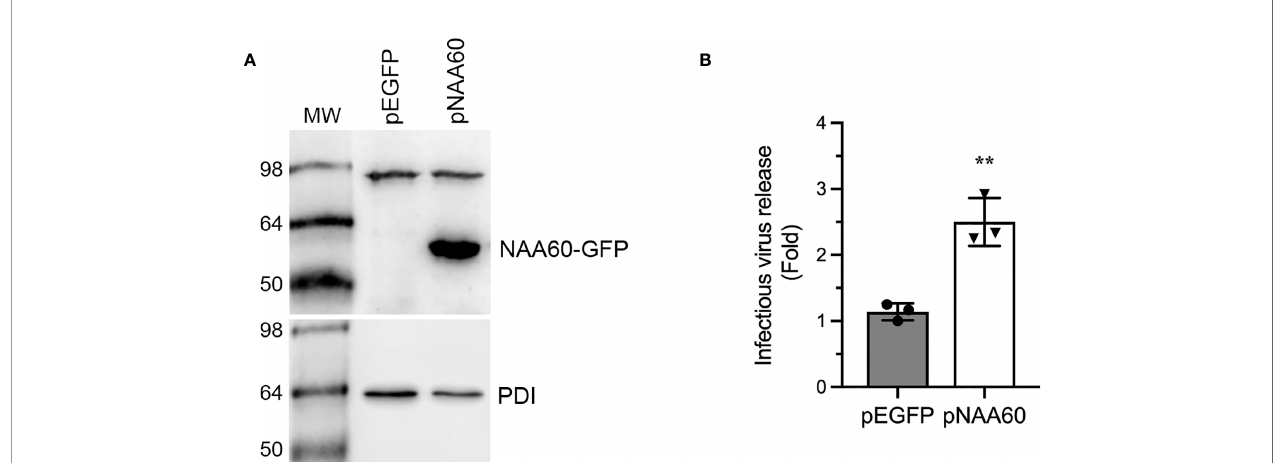
FIGURE 2 | The overexpression of NAA60 increases IAV infection. HEK293T cells were transfected with 1µg of pEGFP or pNAA60 plasmid for 24 h and subsequently infected with PR8 at an MOI of 1.0 for 24 h. (A) The cells were processed to detect the NAA60-GFP fusion (56 kDa) and PDI (57 kDa) polypeptides by western blotting. (B) The culture medium was titrated by microplaque assay to determine the viral progeny release. The amount of viral progeny released from pEGFP plasmid transfected cells was considered 1-fold to determine the viral progeny released from pNAA60 plasmid transfected cells. Error bars represent means ± standard deviation of at least three biological replicates; **P ≤ 0.01. MW, molecular weight; Grey bar, CTRL; White bar,